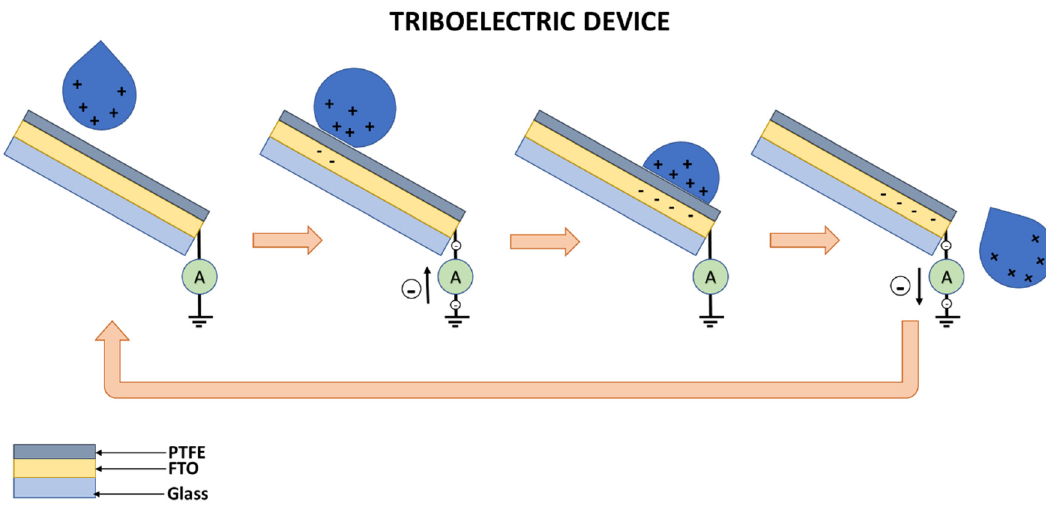
Figure 6. Triboelectric transducer for electrostatic to electric energy conversion of rain. Liang and co-workers [23] proposed a transparent triboenergy nanogenerator (T- TENG) that uses a single electrode, preferable for harvesting mechanical energy from con- tinuously flowing water, a thin (1 μ m) film with an overlap of hydrophobic, less than 3 μ m thick poly(tetrafluoroethane) (PTFE) film, was used. The transmittance of the con- structed device was found to be larger compared to the glass substrate. It reached a 10 V output peak-to-peak open-circuit and 2 μ A/cm 2 current density, with instantaneous out- put power density of 11.56 mW/m 2 when a load resistor of 0.5 M Ω was connected to the device. The rectified output charged commercially available capacitors and a light emit- ting diode. The architecture of the T-TENG included a rectangular glass substrate (due to its good transparency strength and machinability) and a PTFE and fluorine-doped tin ox- ide electrode. The fabrication process was simple and did not require any sophisticated equipment. PTFE has been selected due to its hydrophobic nature, resulting in self-clean- ing, anti-sticking, and de-icing. It was also critical for TENG performance. Transmittance